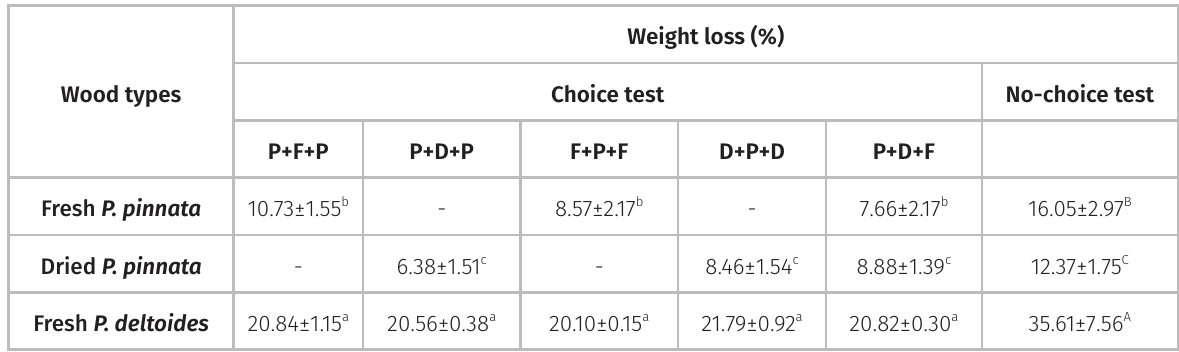
Table I. Comparison of mean weight losses of fresh P. pinnata , sun-dried P. pinnata , and P. deltoides after 28 days exposure to subterranean termites in choice and no-choice field